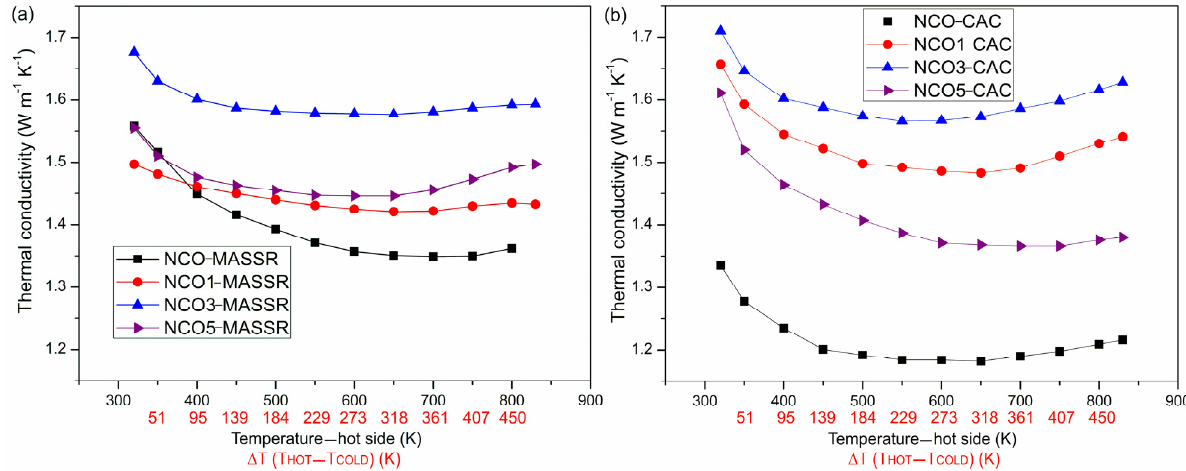
Figure 4. Temperature dependence of the thermal conductivity of the ( a ) MASSR and ( b ) CAC samples for the temperature gradients Δ T at the temperatures of the hot side of the samples.